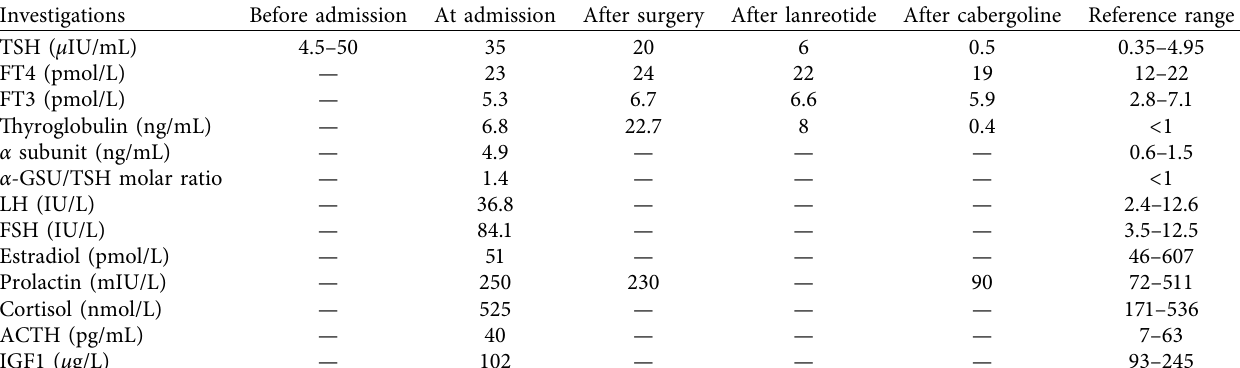
Table 1: Pertinent laboratory